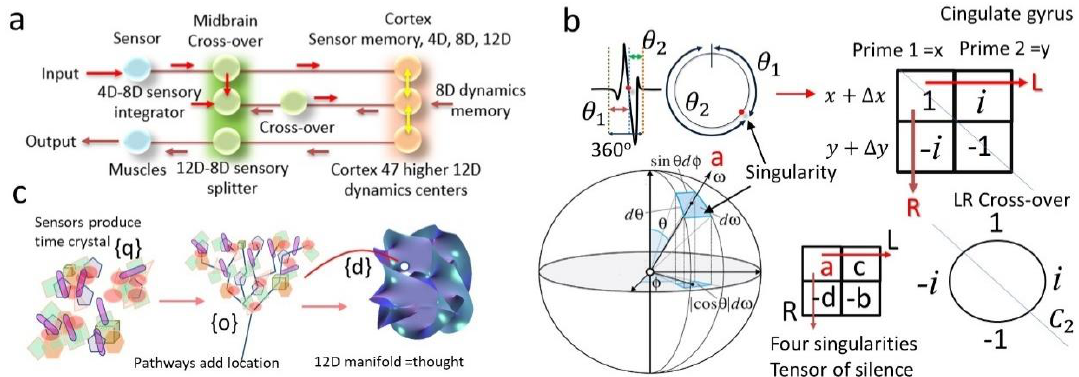
Figure 1. ( a ) Three layered input-output network of brain’s information processing. ( b ) Three steps for the time crystal based information processing in the brain [42]. The sensor’s time crystal as quaternion, pathway based fusion of time crystal as octonion and finally expanding the information to the 12D manifold, a dodecanion. ( c ) The phase space allocation of brain’s information where the components in the brain selectively play the role of diagonal driver of a tensor holding the information for the singularity points. The basic process of writing a time crystal using a 2 × 2 tensor.